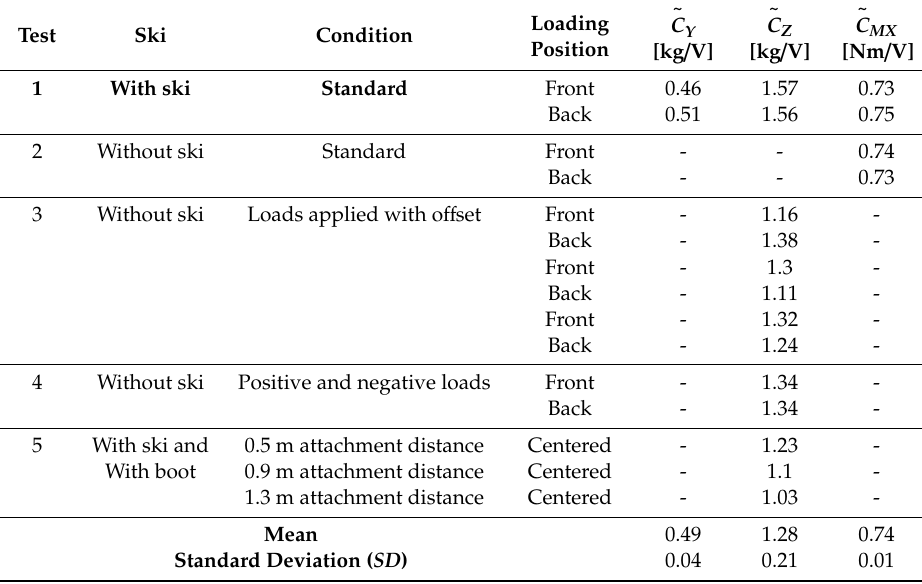
Table 1. Description of the five di ff erent tests conditions with the corresponding averaged calibration coe ffi cients (cid:101) C as described in Equations (5)–(7).